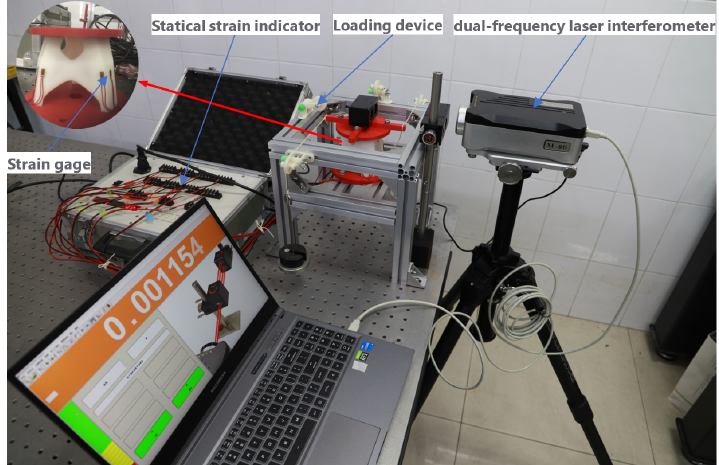
Figure 6. Experiment platform for sensitivity of soft sensor.